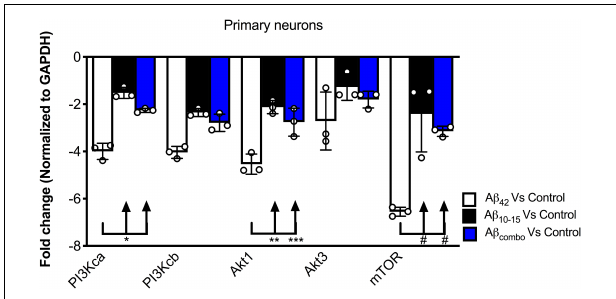
FIGURE 5 | Impact of N-A β core on regulation of various PI3 kinase, Akt and mTOR transcripts by A β . Primary mouse hippocampal neuron cultures were treated with 1 µ M full-length A β 42 , 1 µ M A β 10 − 15 (N-A β core) or the combination (combo). Extracted RNA was subjected to qPCR, probing for Class 1 PI3 kinase catalytic subunits (CA and CB), Akt1 and Akt2 and mTOR. Data are expressed as averaged fold-change over untreated controls, after normalizing for GAPDH expression. Bars are means ± SD. * p = 0.00063; ** p = 0.000002; *** p = 0.0001; # p = 0.000001 (Bonferroni post hoc tests for one-way ANOVA comparisons, as shown). For each condition, N = 3